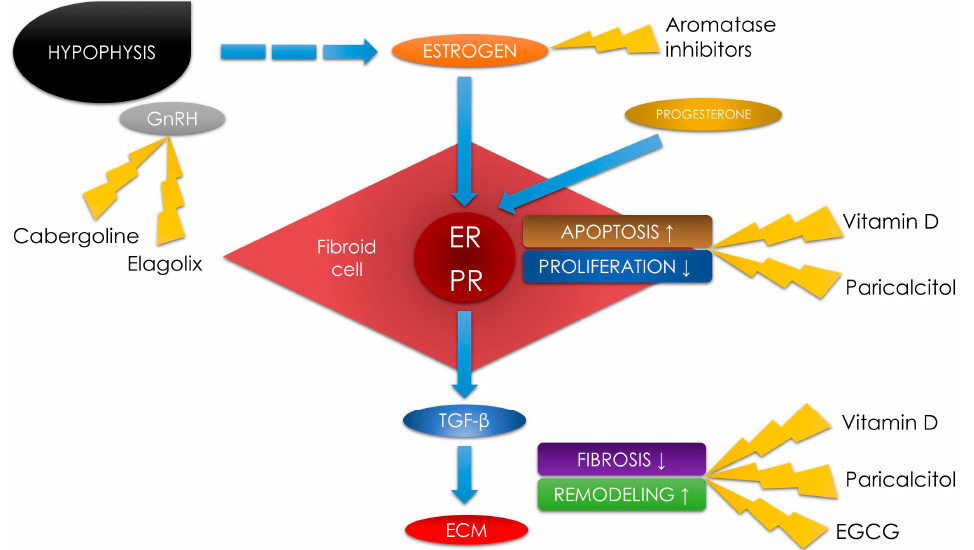
Figure 1. Schematic diagram of uterine fibroid pathophysiology with places for potential use of an alternative agent therapy. Gonadotropin-releasing hormone (GnRH), estrogen receptor (ER), progesterone receptor (PR), transforming growth factor beta (TGF- β ), extracellular matrix (ECM), epigallocatechin gallate (EGCG).